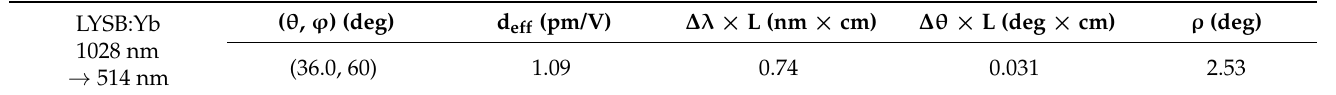
Table 9. NLO properties for SHG of type I of the fundamental wavelength of 1028 nm in LYSB:Yb